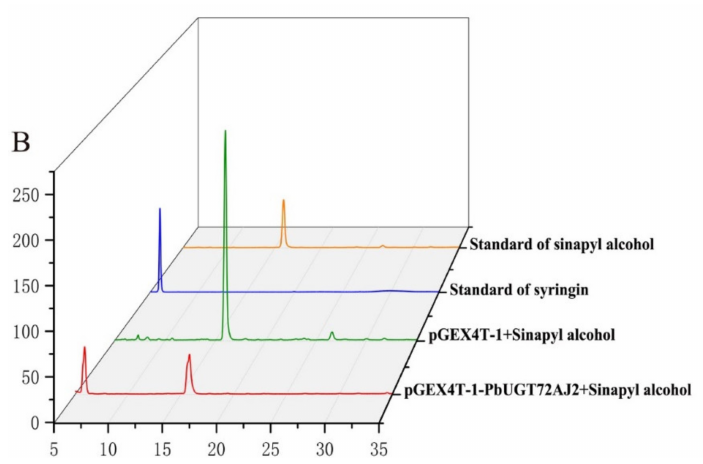
Figure 4. Enzyme activity of PbUGT72-pGEX-4T-1 recombinant protein toward coniferyl alcohol and sinapyl alcohol. ( A ) HPLC analysis of Standards: coniferyl alcohol, coniferin, and after reaction coniferyl alcohol with PbUGT72AJ2-pGEX-4T-1 recombinant protein. ( B ) HPLC analysis of Stan- dards: sinapyl alcohol, syringin, and after reaction sinapyl alcohol with PbUGT72AJ2-pGEX-4T-1 recombinant